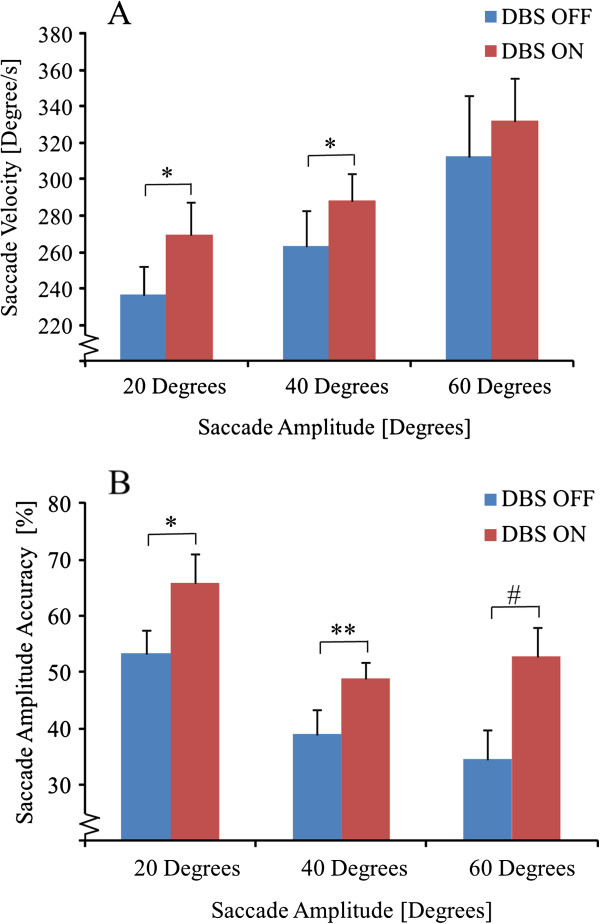
A Saccade eye movement velocity (mean and SEM) for three saccade amplitudes with DBS OFF and ON. B: Saccade amplitude accuracy in percentage (mean and SEM) with DBS OFF and ON. A value of 100 represents perfect saccade amplitude accuracy whereas values below 100 represent short saccades (hypometric) (# denotes P < 0.1; * denotes P < 0.05; ** denotes P < 0.01 and *** denotes P < 0.001).